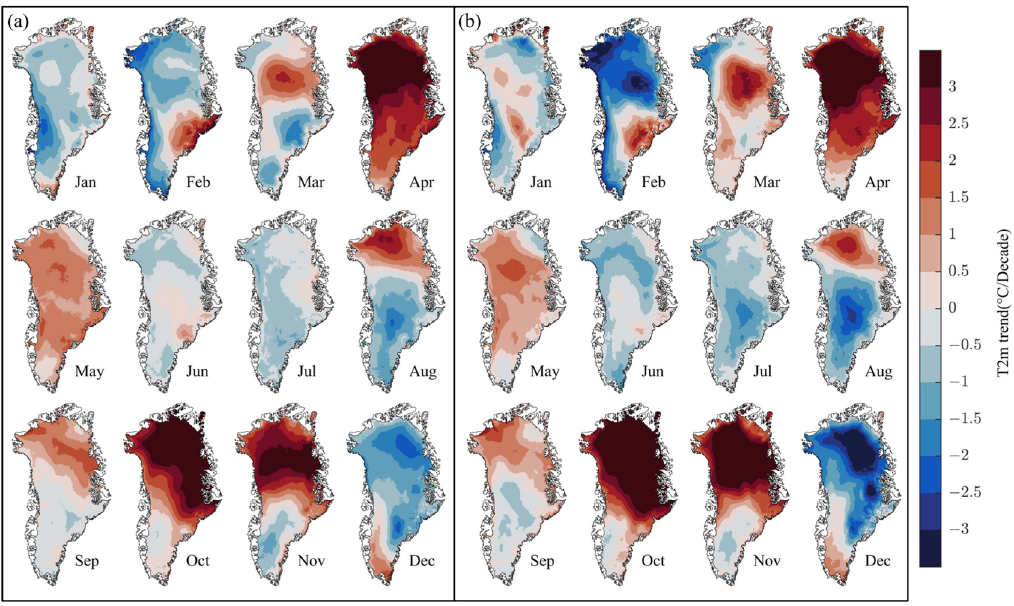
Figure 8. Monthly T2m trend ( ◦ C decade − 1 ) from 2007 to 2019 from NN Reconstruction ( a ) and RACMO2.3p2 ( b ).